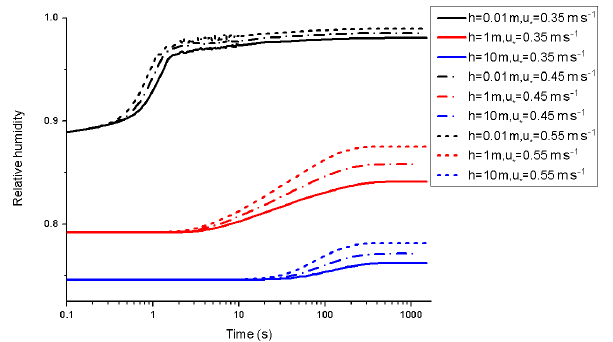
Figure 8. Temporal evolution of relative humidity for various heights.